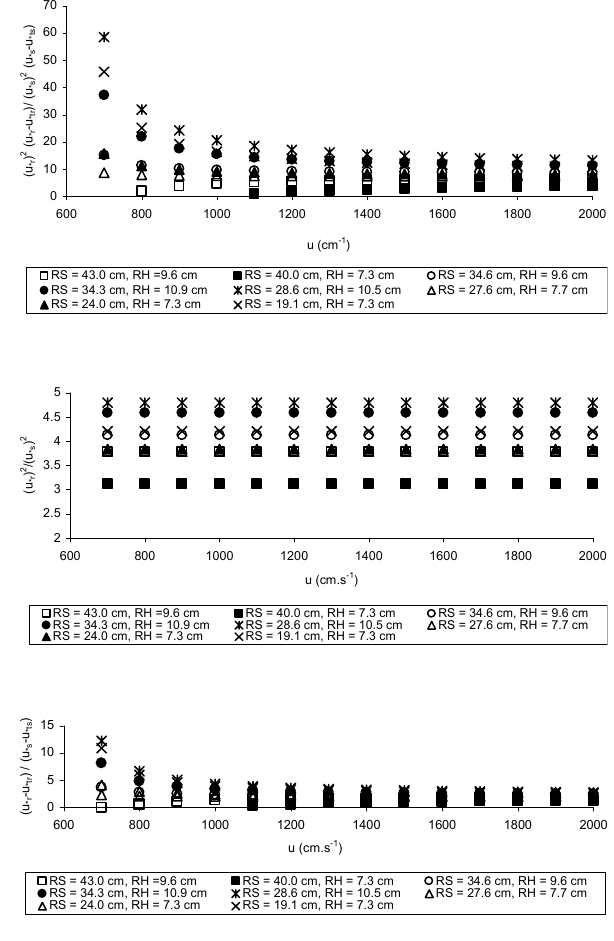
Fig. 13. Increases in wind erosion horizontal fluxes due to the aero- dynamic effect, (a) total aerodynamic effect, (b) [ (u ∗ s ) 2 / (u ∗ r ) 2 ], (c) (u ∗ s − u ∗ ts )/(u ∗ r − u ∗ tr ) (see text for details).